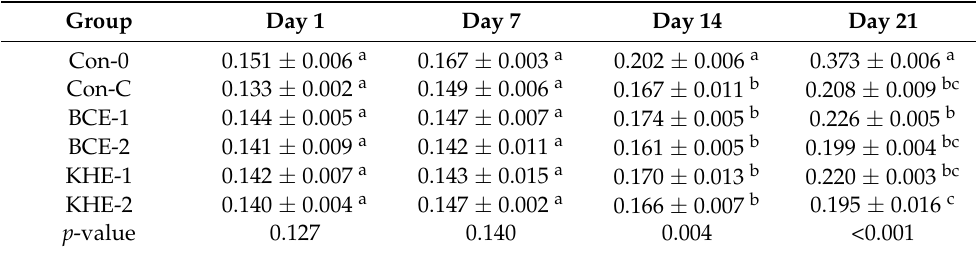
Table 6. Effect of extract addition on production of malondialdehyde (MDA) expressed as MDA concentration in samples (mg · kg − 1 ± standard